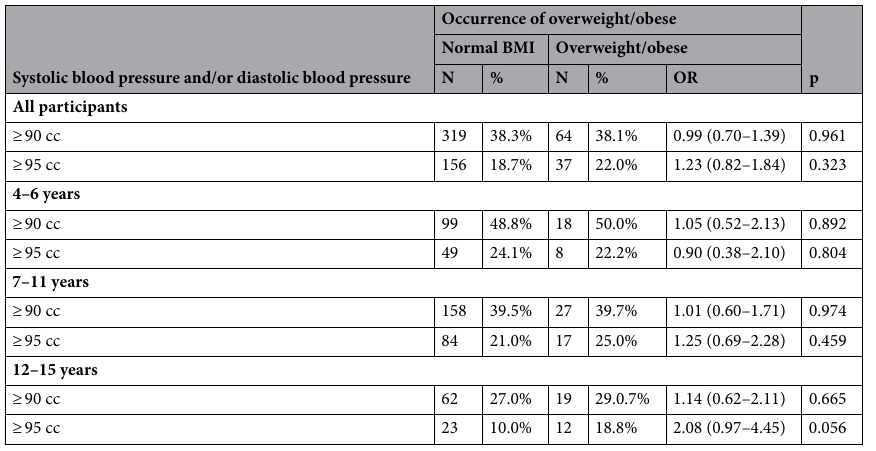
Table 5. The occurrence of arterial hypertension depending on the body weight of the examined